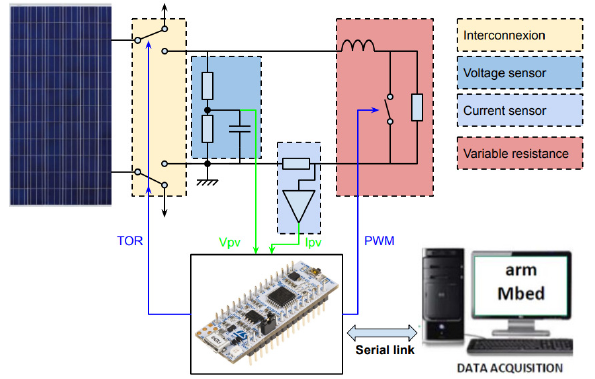
Figure 4. Acquisition time .